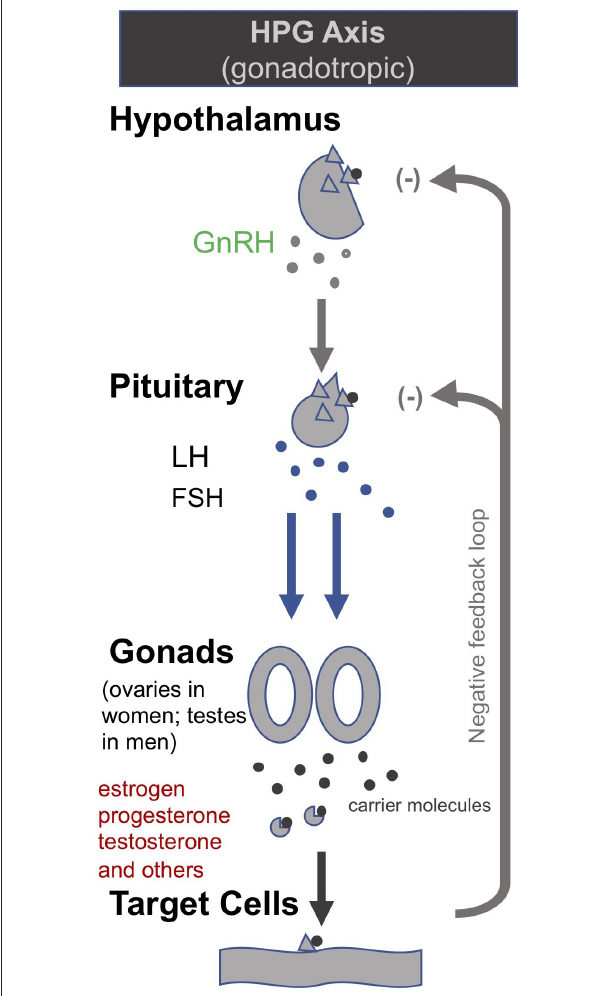
FIGURE 4 | The gonadotropic (HPG axis) [modified from (34)].